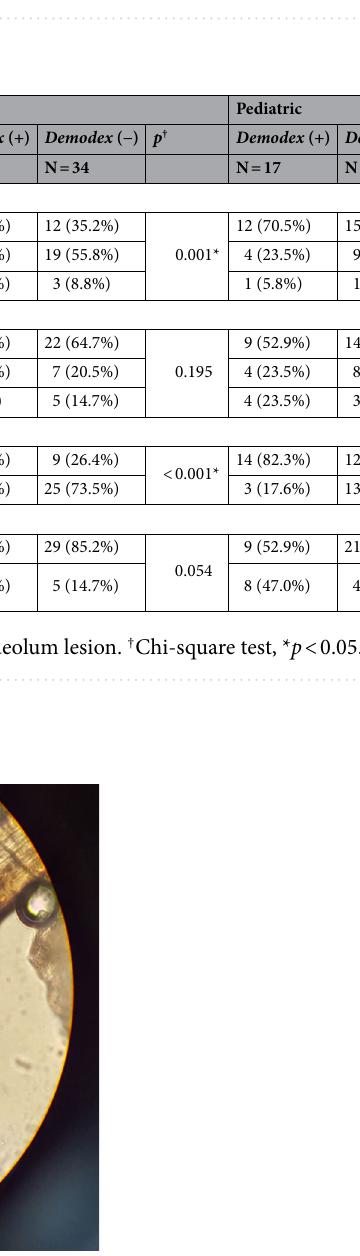
Table 1. The prevalence of Demodex mites in recurrent hordeolum group and control group. Recurrent group: Recurrent hordeolum patient group. Values are expressed as the mean ± standard deviation. M = Male, F = Female. † Chi-square test. * p < 0.05.